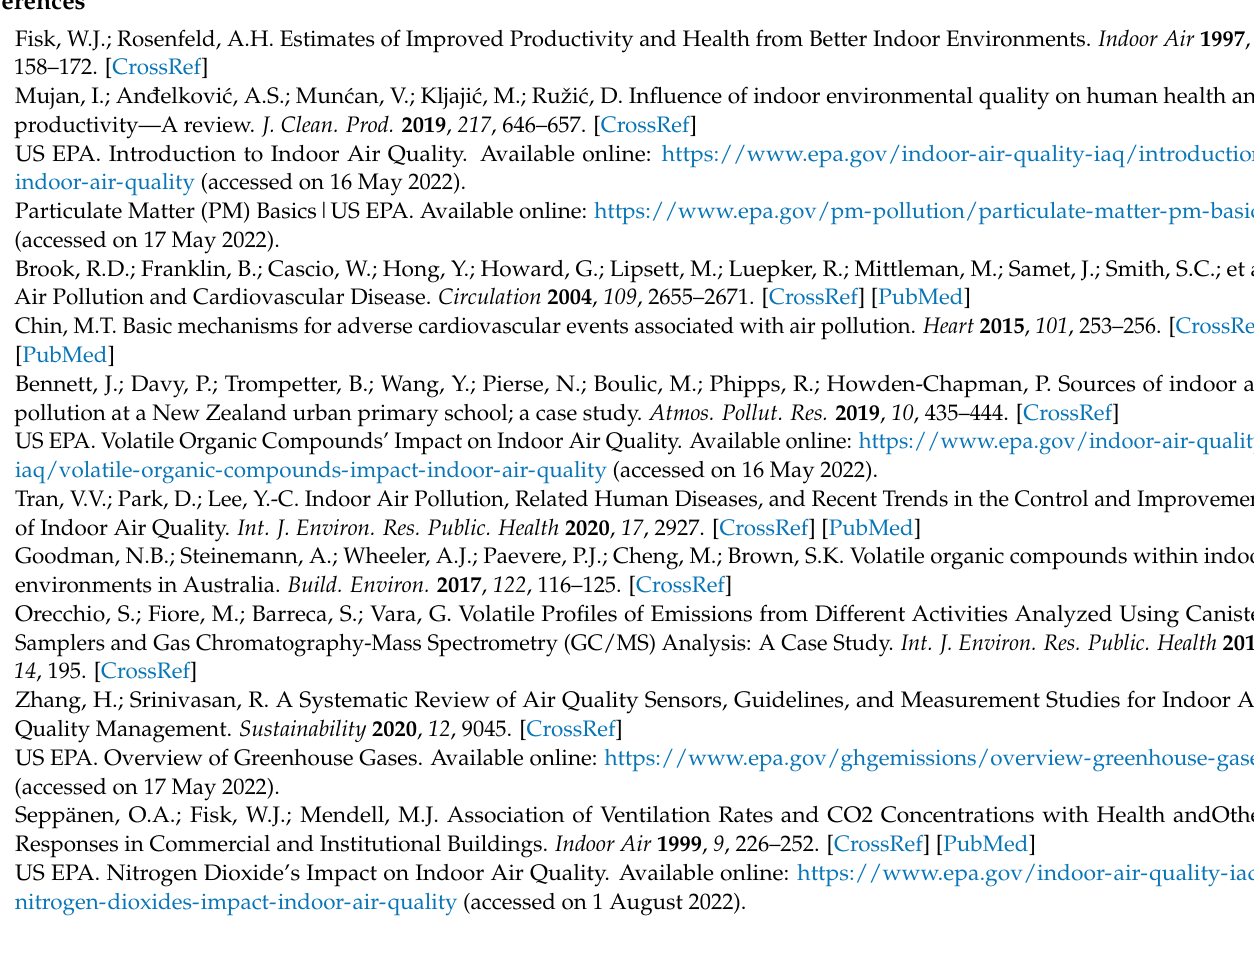
Figure A9. Sensor placement for the factory room.